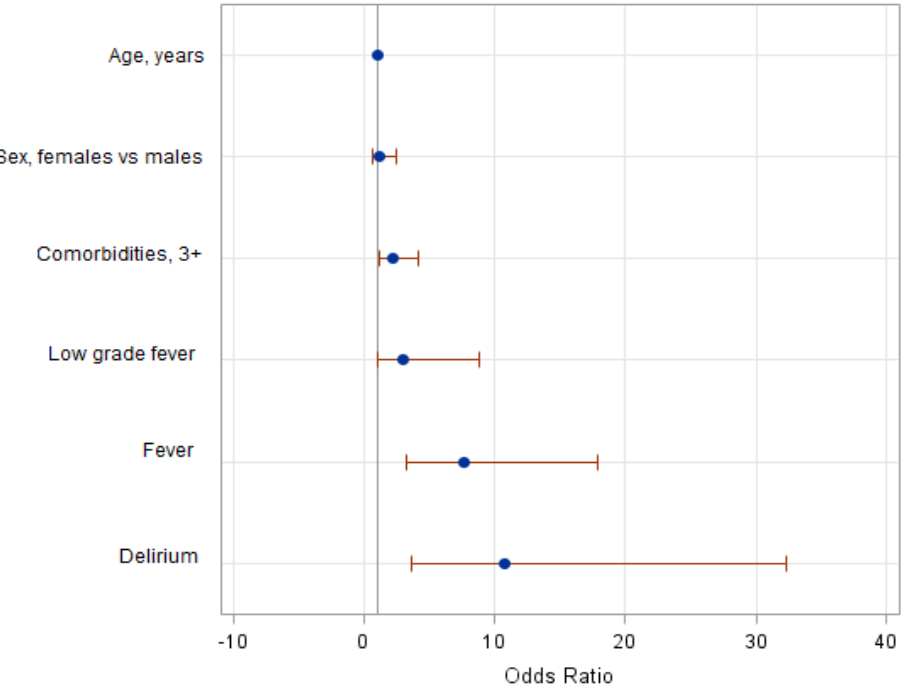
Figure 1. The associations between clinical features and SARS-CoV-2 infection (according to PCR swab testing). Logistic regression model using stepwise analysis (sle = 0.15; sls = 0.20), adjusted for age, sex, and comorbidity (defined as having 3+ chronic diseases). Symptoms reported by at least 5% of study participants (including fever, low-grade fever, cough, dyspnea, low oxygen saturation at rest, weakness/prostration, delirium, anorexia, diarrhea, sudden worsening of health status, diuresis contraction, urine or feces incontinence, inability to ask questions, inability to fill a self-evaluation questionnaire) were considered possible independent variables.